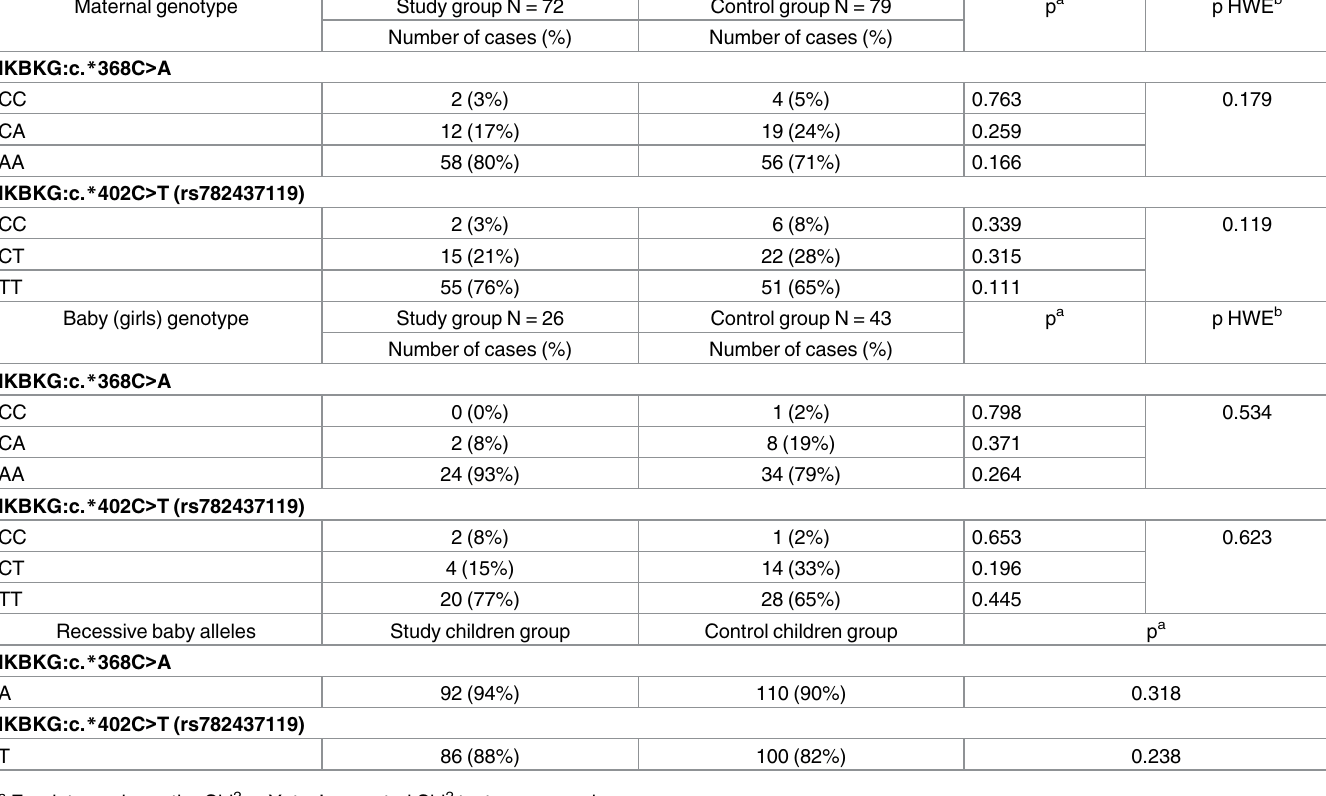
Table 3. Comparison of genotype frequency between mothers of the study and control groups, between daughters of the study and control groups, and a comparison of recessiveallele frequency between children of the study and control groups. Maternal genotype